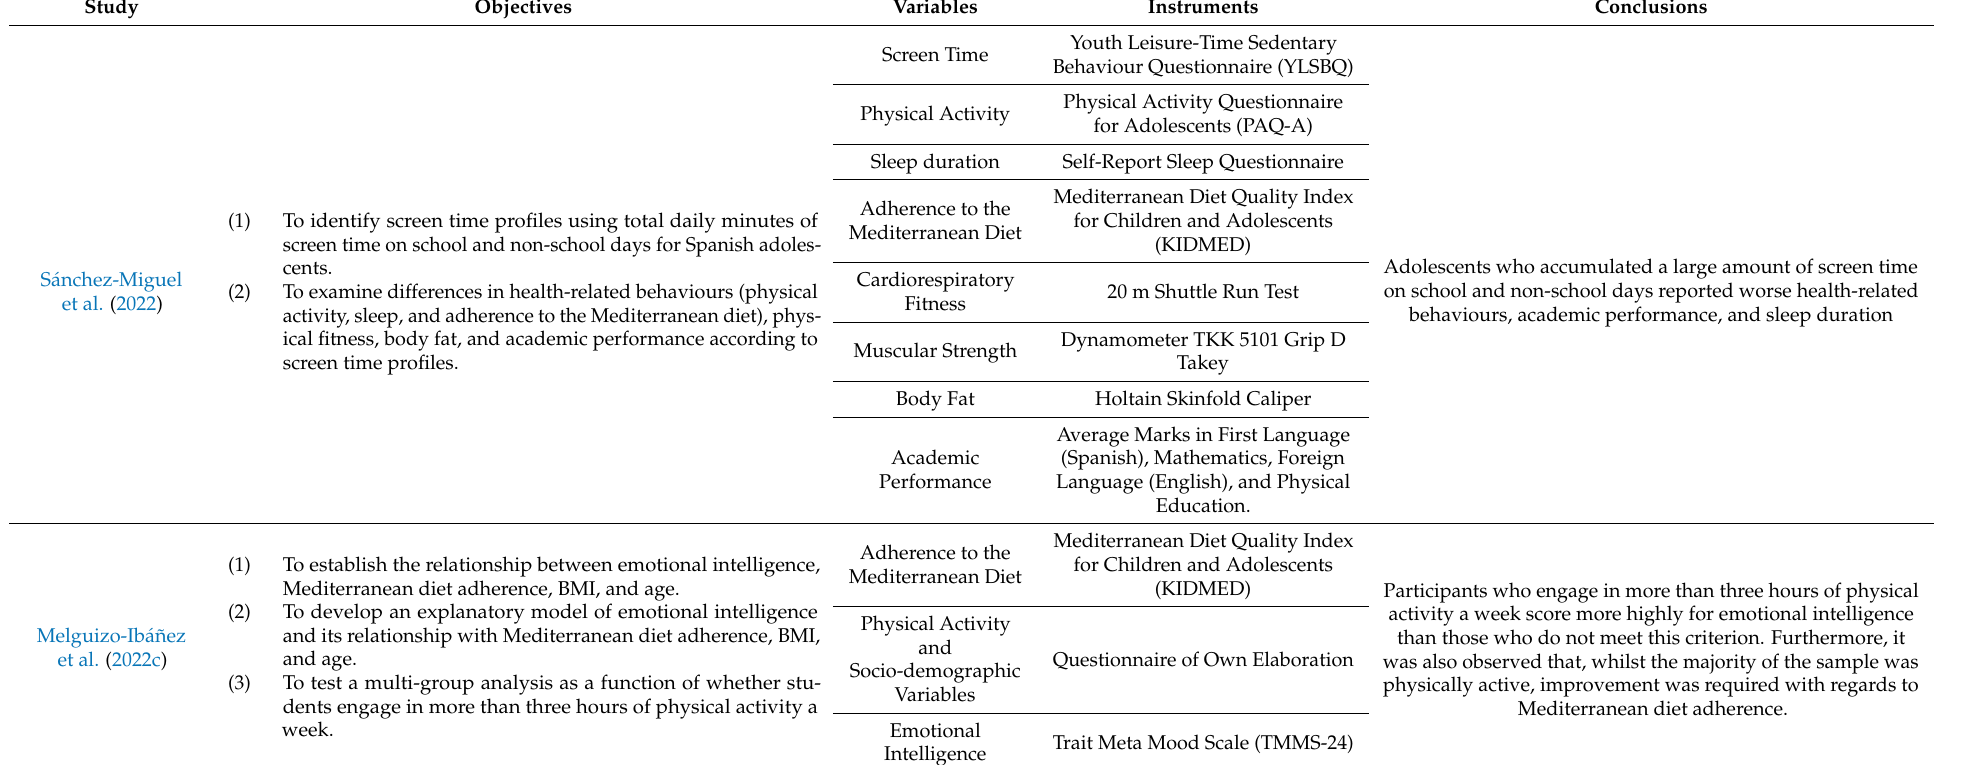
Table 3. Objectives, variables, instruments, and conclusions obtained from the various research studies